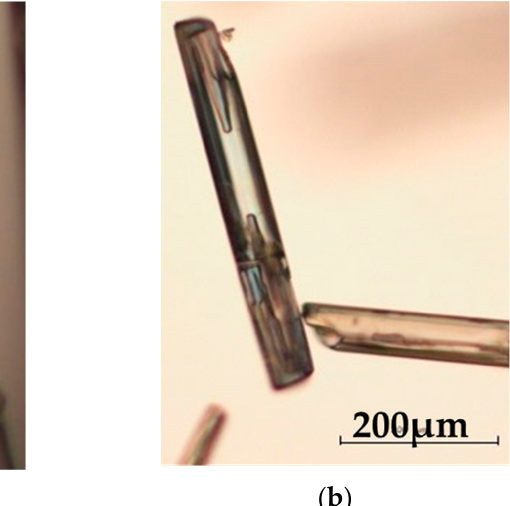
Figure 10. ( a ) Molecular chain of S-IBU/S- α -MBA spreading along the ‘a’ axis. The carbon atoms are displayed in yellow for S- α MBA and in grey for S-IBU. Chiral carbon for both molecules is highlighted with an asterisk. ( b ) Projection along the ‘a’ axis of the S-IBU/S- α -MBA crystal structure. The slices {002} and {011} are shown; their surfaces are clearly hydro- phobic.